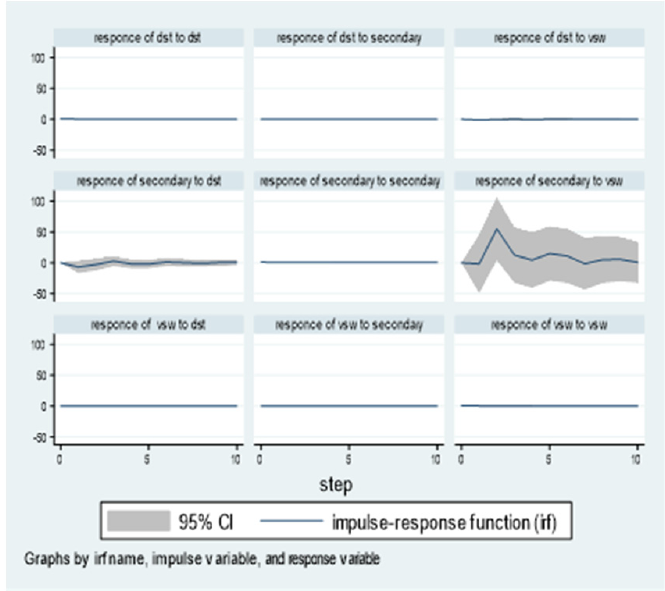
Figure 4. Response of electricity consumption of the secondary sector to space weather .